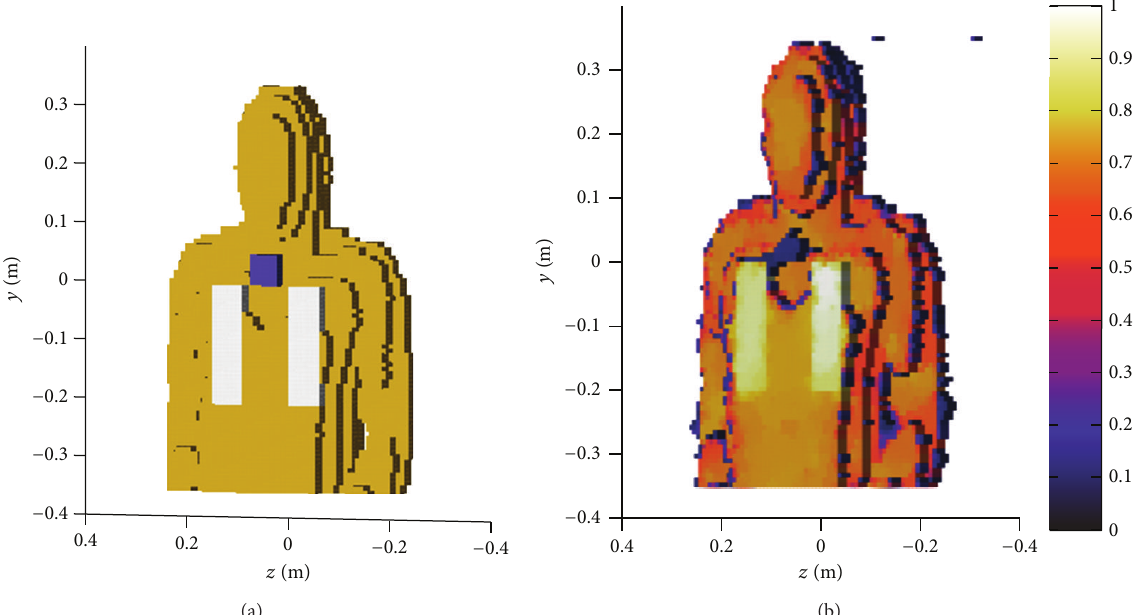
Figure 7: Three dimensional images created using voxels: (a) ground truth and (b)